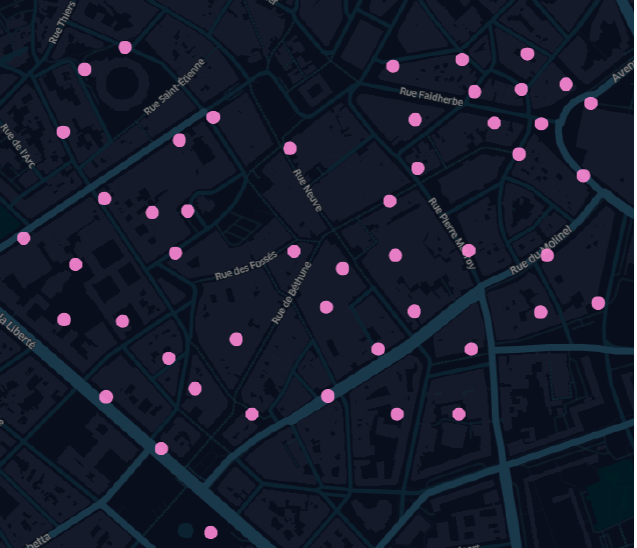
Figure 3. Fifty sparsely located sensor maps in the Lille city center. The dots represent the